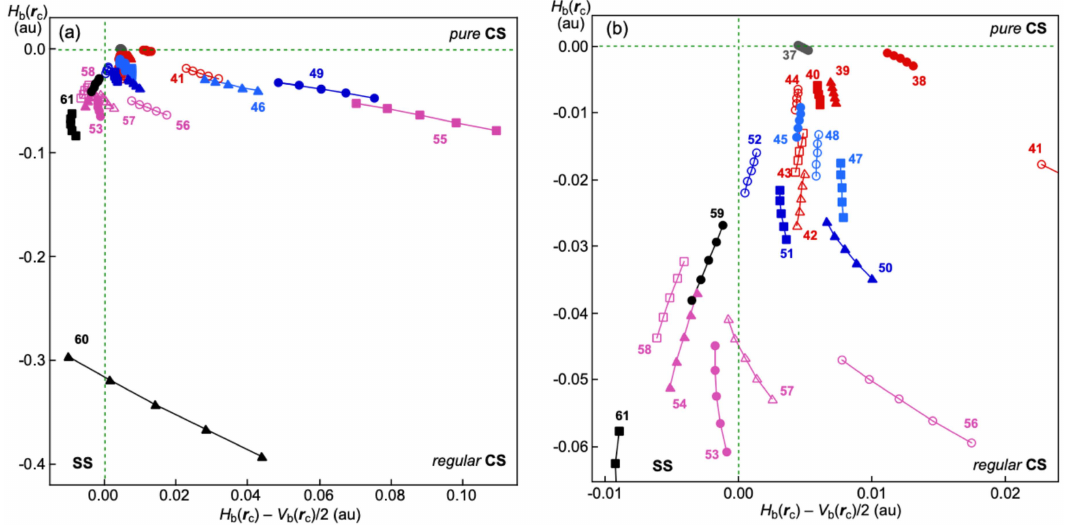
Figure 3. QTAIM-DFA plots of H b ( r c ) versus H b ( r c ) − V b ( r c )/2 for 37 – 61 calculated under MP2/BSS- A’: ( a ) whole picture of the plots and ( b ) the partial one. The perturbed structures are generated with CIV. The numbers and colors in the figure are the same as those in Table